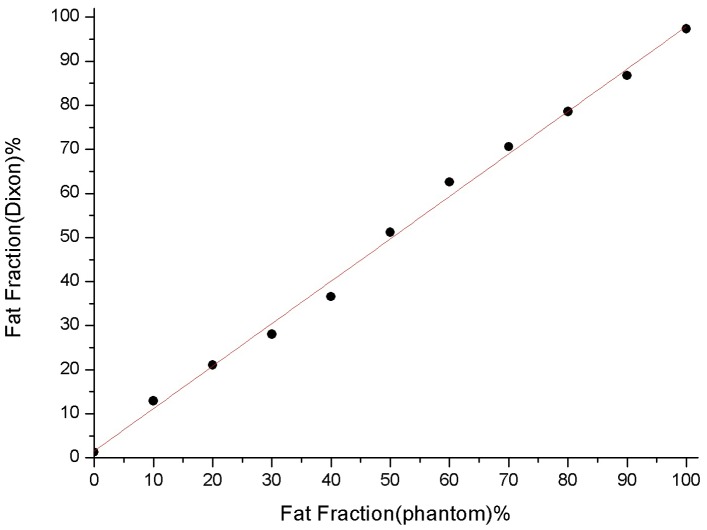
Correlation of actual fat volume fraction (FVF) of the water/fat phantoms against the mean fat fraction computed from Dixon technique.The best-fit-line was displayed. (r2 = 0.994, p = 0.000).